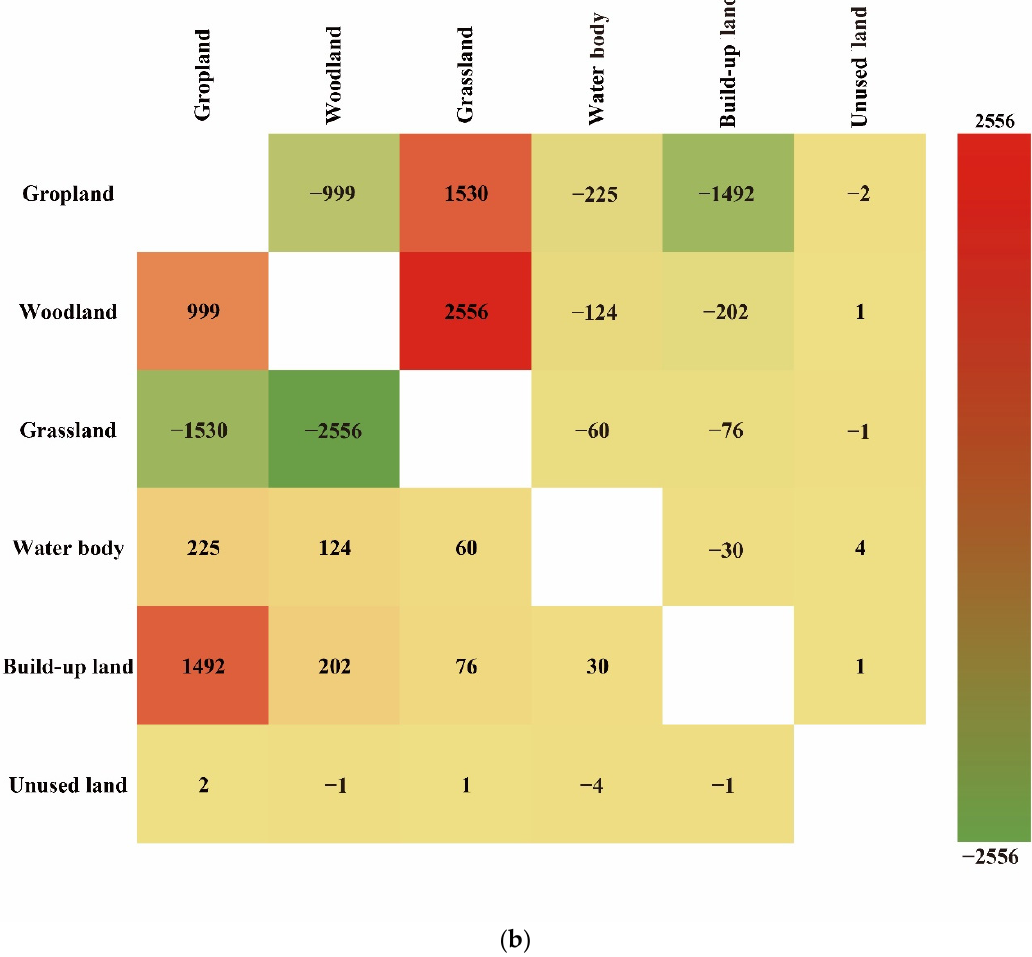
Table 4. 1990–2020 Land Use Transfer Matrix (unit: km 2 ).